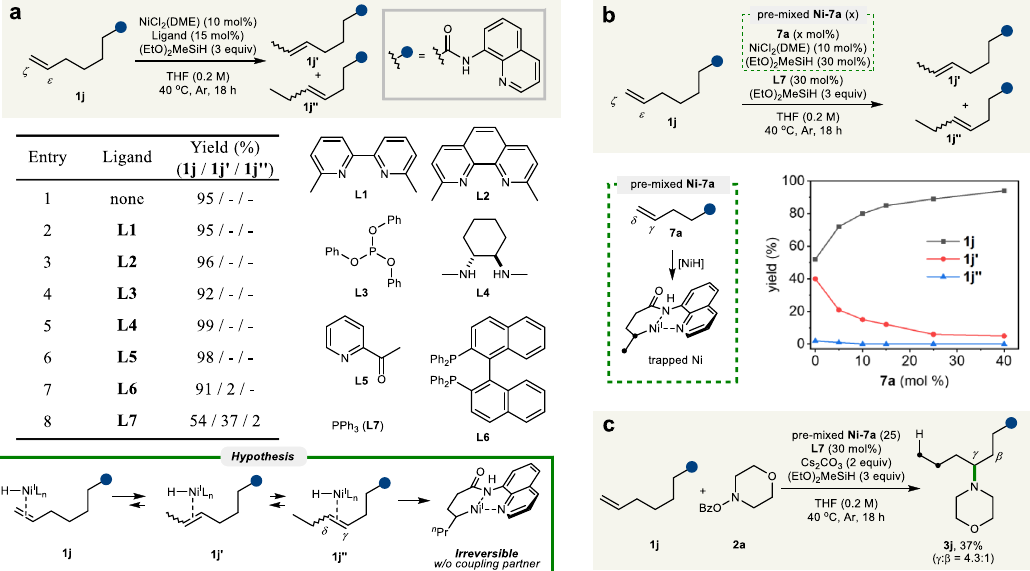
Fig. 2 Preliminary results. a Ligand screening for alkene isomerization with 1j ; All reactions were performed on a 0.1 mmol scale; Yields were determined by 1 H NMR spectroscopy; 30 mol% of L3 , L5 , L7 were used; THF: tetrahydrofuran. b Sequestration of a nickel catalyst. c Migratory hydroamination with a sequestered nickel